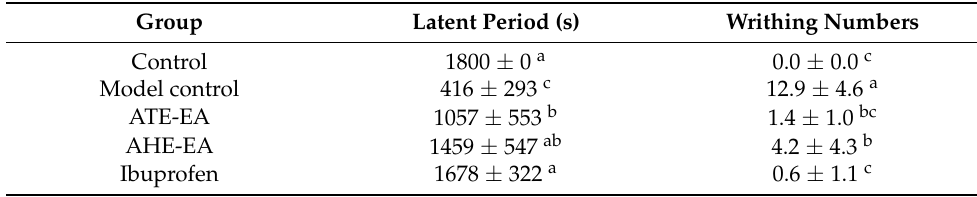
Table 2. Effect of ATE-EA and AHE-EA on the oxytocin-induced writhing response in estrogen-treated mice. The latent period and number of writhes was counted for 30 min after oxytocin ad- ministration.